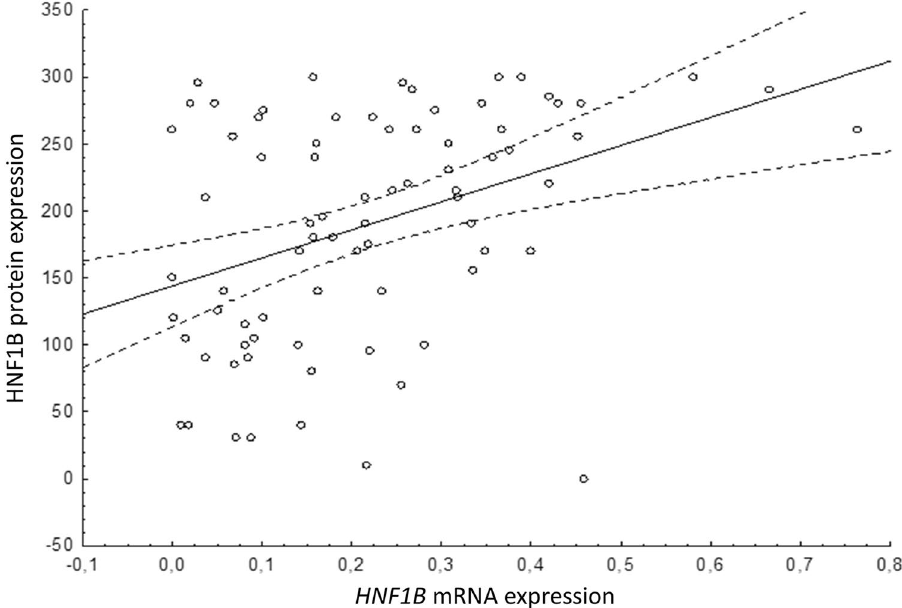
Figure 3. Correlation of the overall HNF1B mRNA and protein expression in 78 large intestine carcinoma samples showed weak positive correlation (R = 0.39; p < 0.001). HNF1B mRNA expression (X axis) is relative to POLR2A ( POLR2A expression = 1). HNF1B protein expression (Y axis) is calculated as H-score. Each dot represents one sample. Dashed lines indicate the 95% confidence intervals for the regression